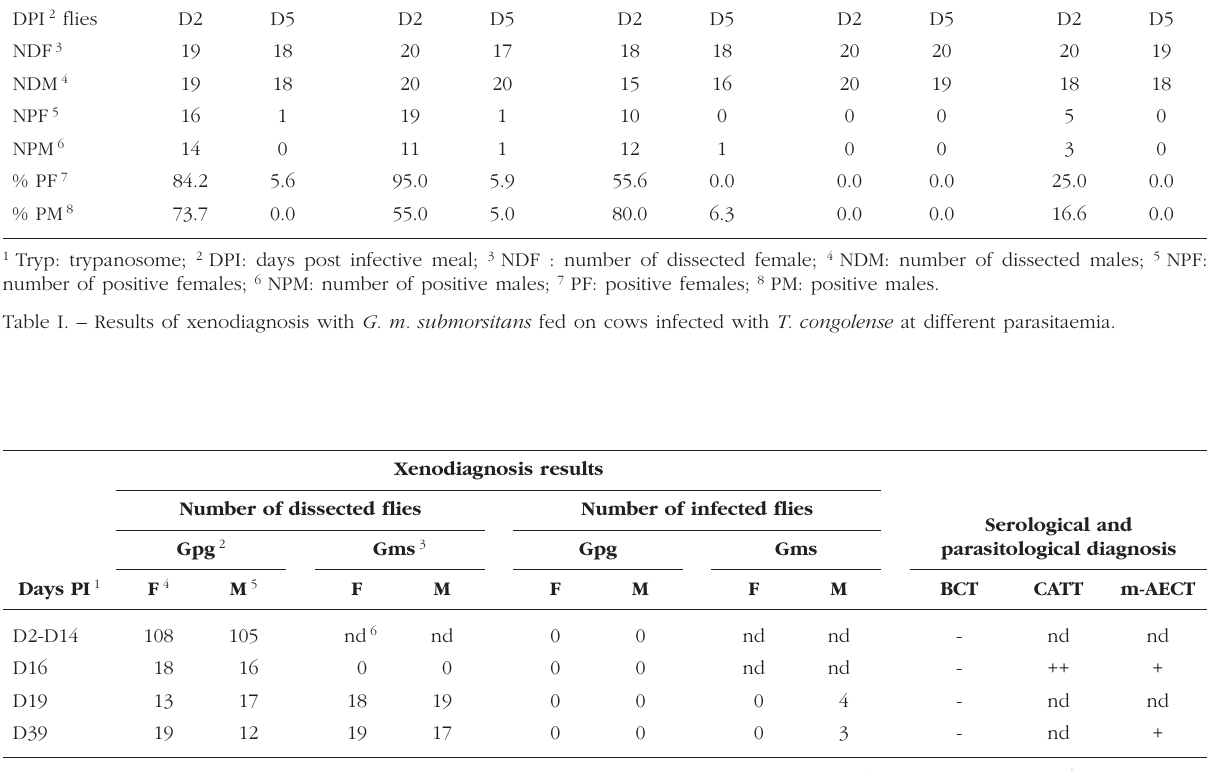
Table II. – Results of xenodiagnosis with G. m. submorsitans and G. p. gambiensis on the infected pig with T. b. gambiense . Results of the serological and parasitological tests performed on the animal are also shown on the right part of the